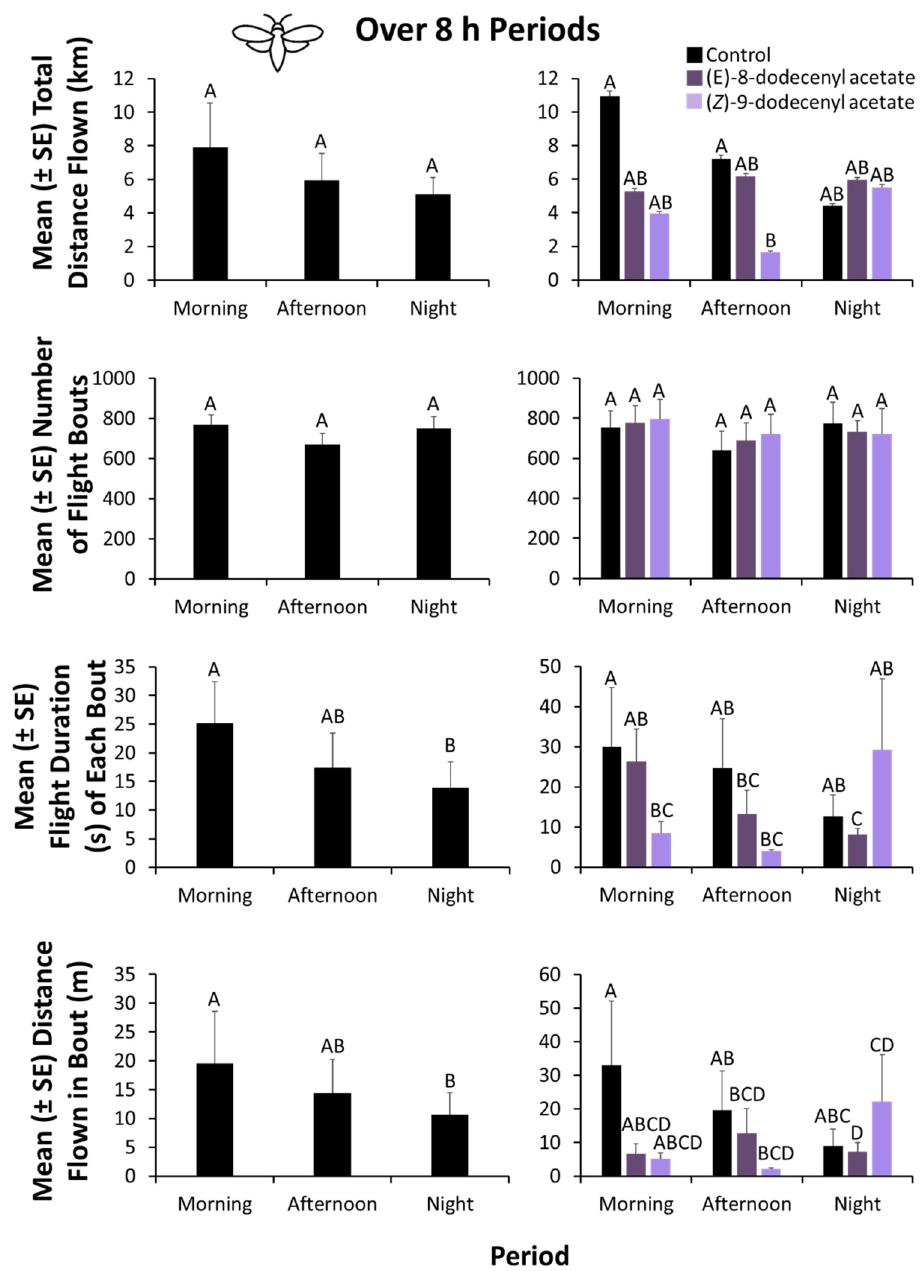
Figure 5. Characterization of flight behavior of E. giganteana on computer-automated flight mills in the laboratory at 8-h increments to determine optimum period of flight (morning, afternoon, or night) over the diurnal time course in the presence of ( E )-8-dodecenyl acetate and ( Z )-9-dodecenyl acetate from the field baiting experiment. A total of n = 18 replicate moths were tested per semio- chemical treatment. Periods are defined as follows: Morning: 4:00–11:59; Afternoon: 12:00–19:59; Night: 20:00–3:59. Bars with shared letters are not significantly different from each other (Tukey HSD, α = 0.05).